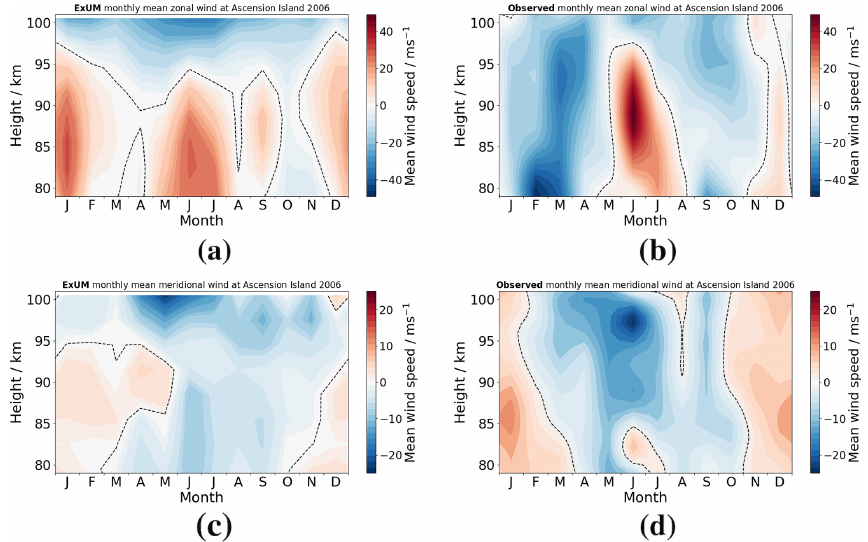
Figure 6. Time–height monthly-mean wind contours at Ascension Island in 2006 comparing (a) ExUM zonal wind with (b) observed zonal wind and (c) ExUM meridional wind with (d) observed meridional wind. The dashed black line represents the zero-wind line. Colour bars are kept consistent left to right for comparison.